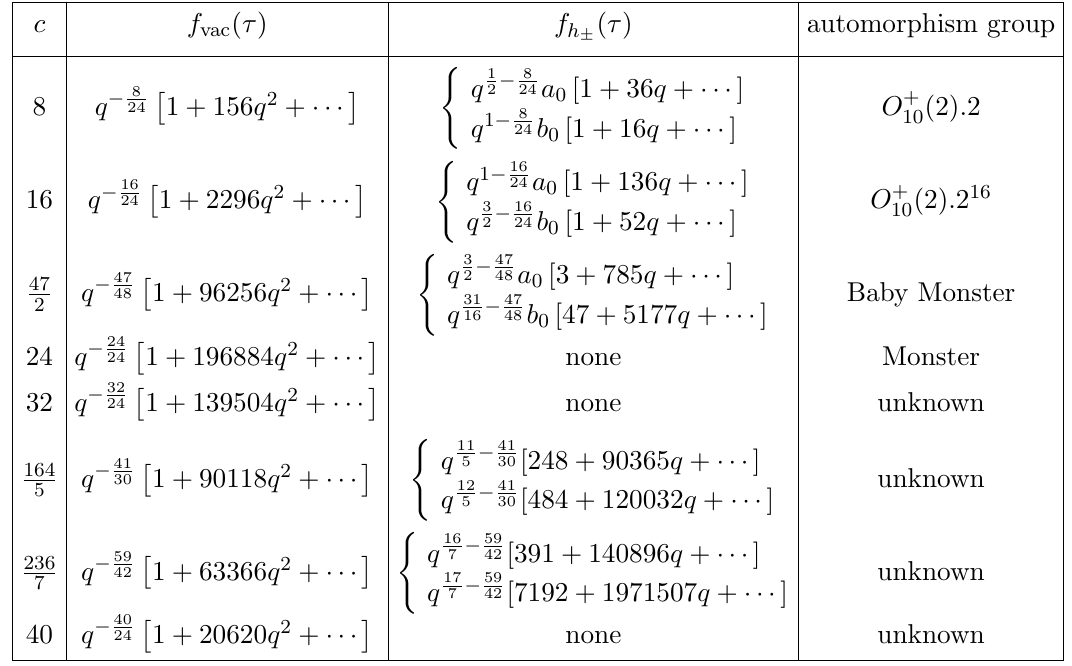
Table 2. Central charge, characters with un(cid:12)xed integers a 0 and b 0 , and automorphism group of eight possible rational conformal (cid:12)eld